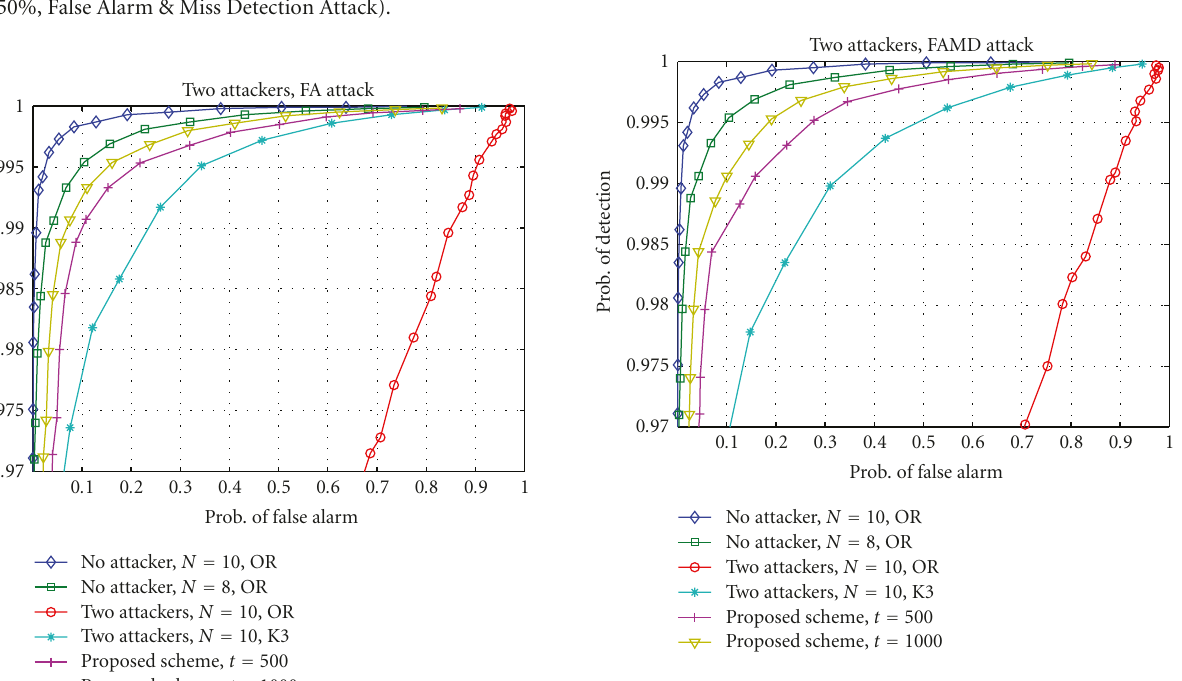
Figure 8: ROC curves (False Alarm & Miss Detection Attack, Two